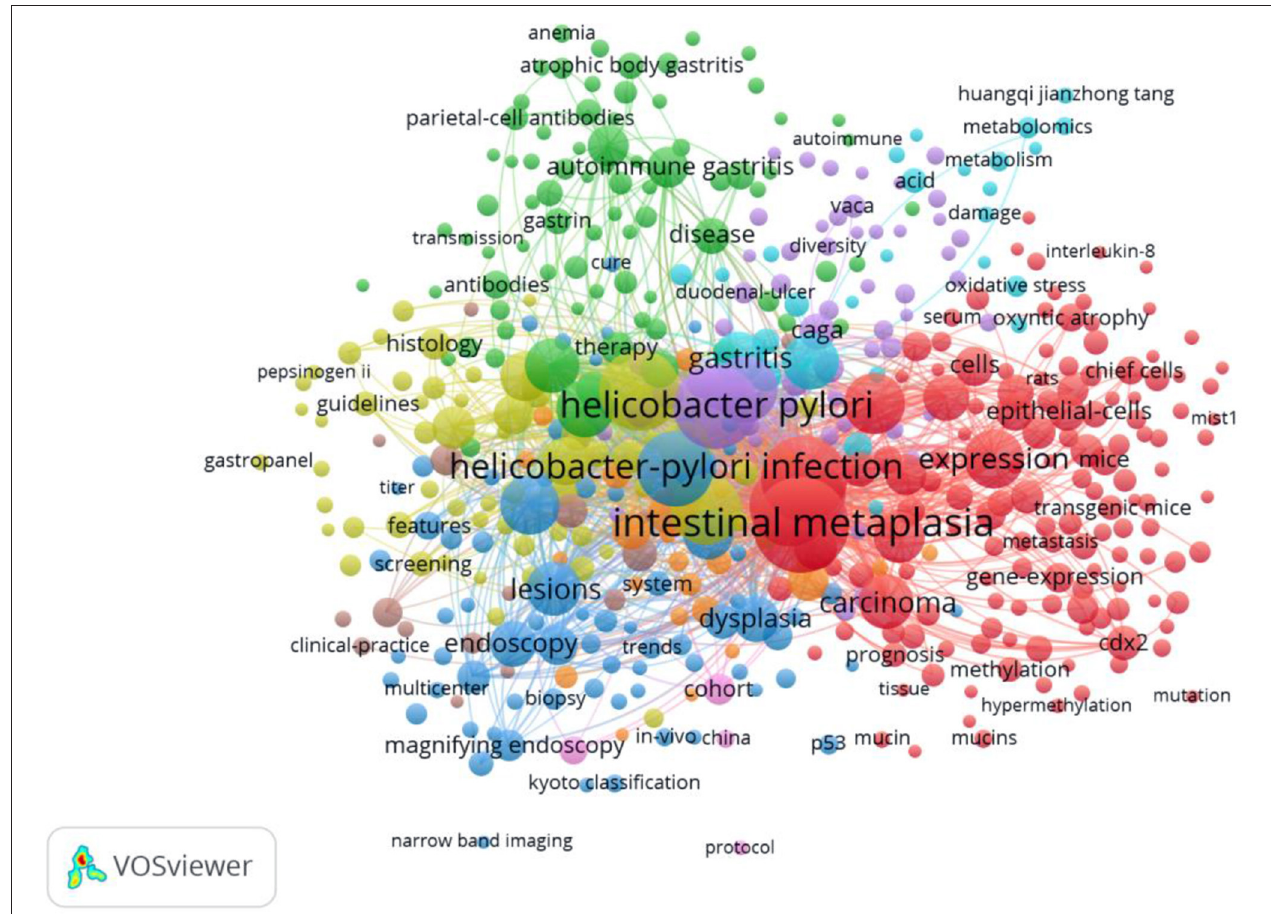
FIGURE 7 | Map of keyword clustering with a minimum of 5 occurrences in AG